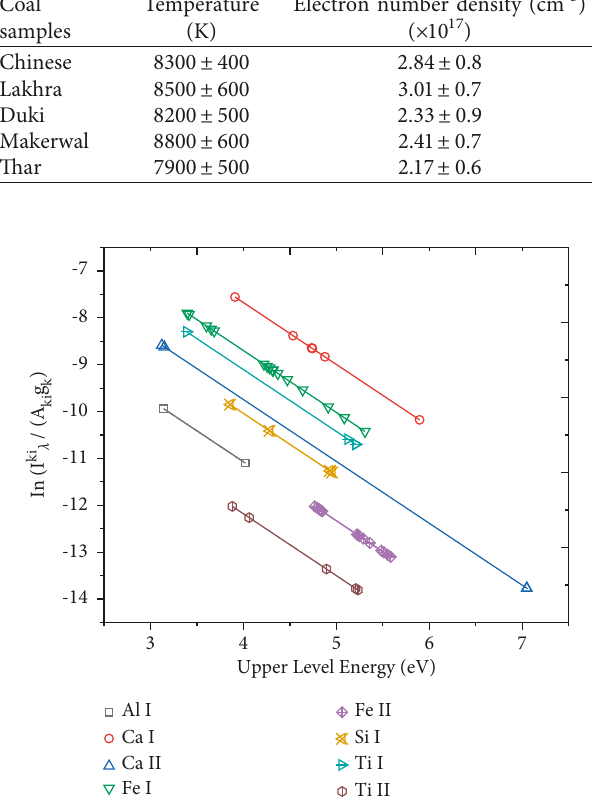
Figure 5: Combined Boltzmann plot with the self-absorption corrected emission lines of Al, Ca, Fe, Si, and Ti elements, the data points are linearly fitted to extract intercept at the fixed slope. Table 2: Quantitative analysis of major elements in coal samples collected from coal mining sites across Pakistan and one Chinese